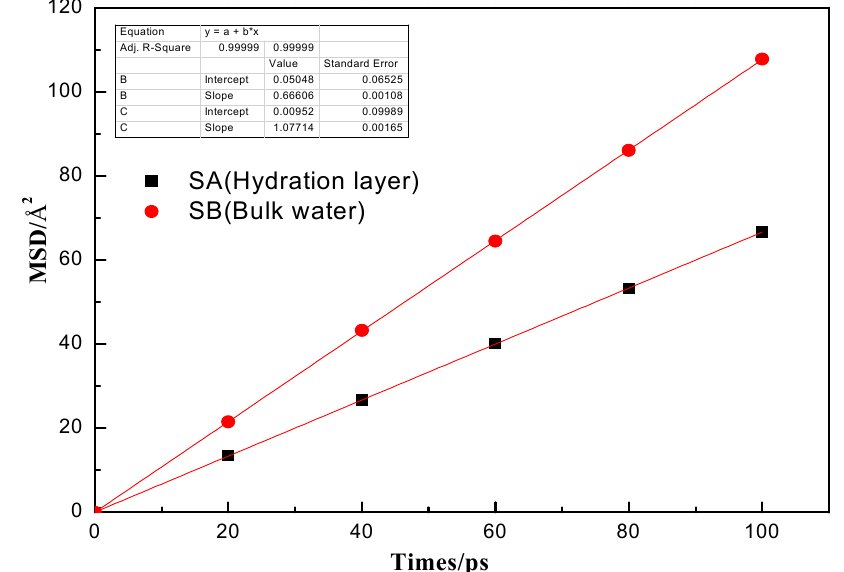
Figure 5. Relative concentration distribution (RCD) of water molecules in the CW system.